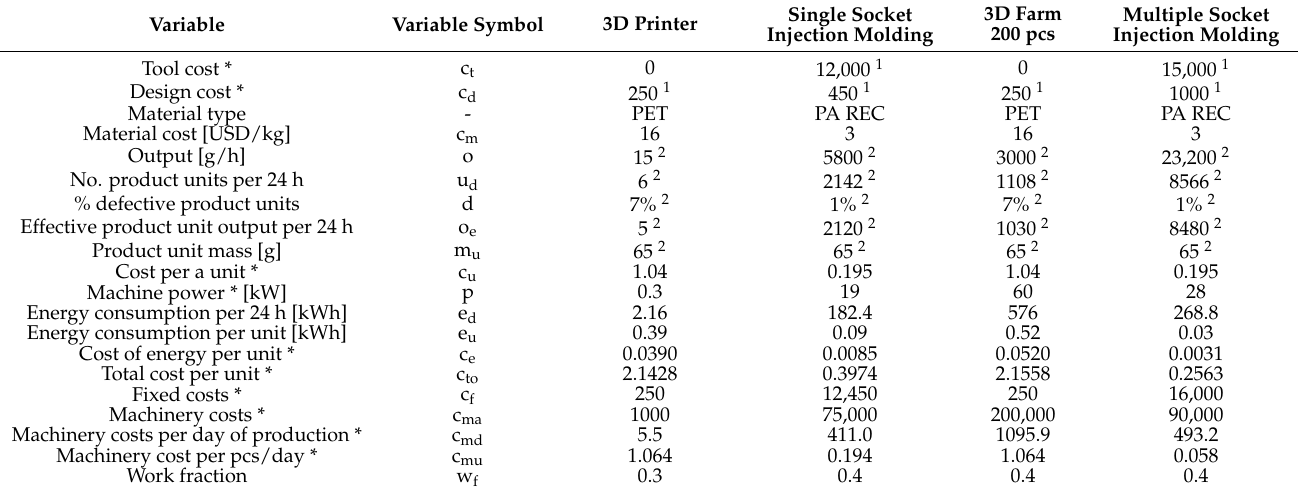
Table 2. A set of parameters for the purposes of the research simulation, based on the literature data and own experimental